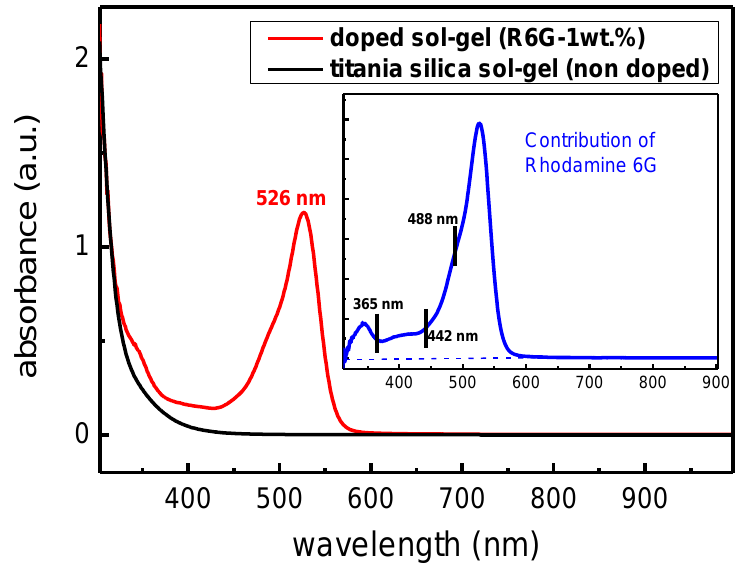
Figure 3. Absorption spectra obtained before γ irradiation on a titania-silica sol-gel film (black line) and a R6G doped sample at 1wt.% (red line). The inset shows the contribution of R6G and corresponds to the absorption difference between the doped and the undoped samples.